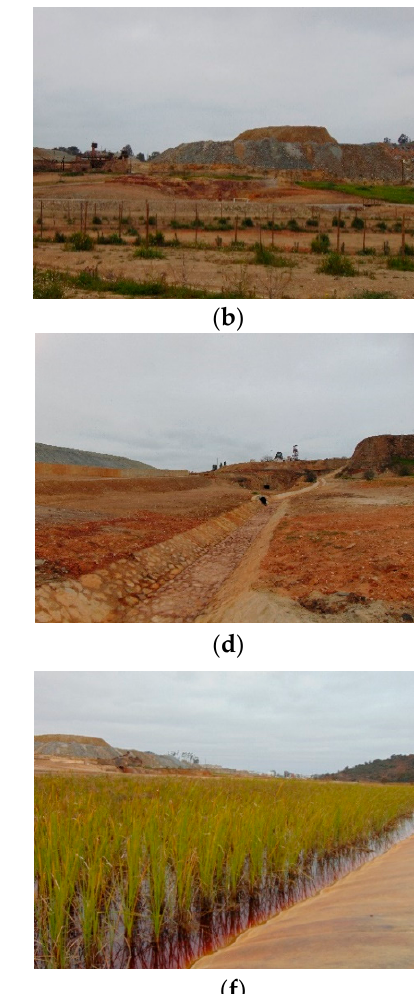
( d ) Figure 3. Valorization of the mining heritage during the remediation measures executed by EDM in the Aljustrel mine for the future Aljustrel Mining Park: ( a ) old cementation tanks; ( b ) the reconstructed Transtagana chimney; ( c ) the rehabilitation made in the Algares +30 level adit (gallery), allowing the observation of ( d ) the formation of secondary minerals through the oxidation of sulfides (Images courtesy of Cátia Micaelo, December 2016). All these interventions are crucial and undoubtably of major importance, with social, economic, and environmental importance to the region. However, conventional constructive techniques can lead to partial or total disruption of the biota and soil structure in the site, which are often fragile, contributing to the deterioration of soil ecosystems [122,124,125]. In addition, conventional dig, dump, and capping techniques